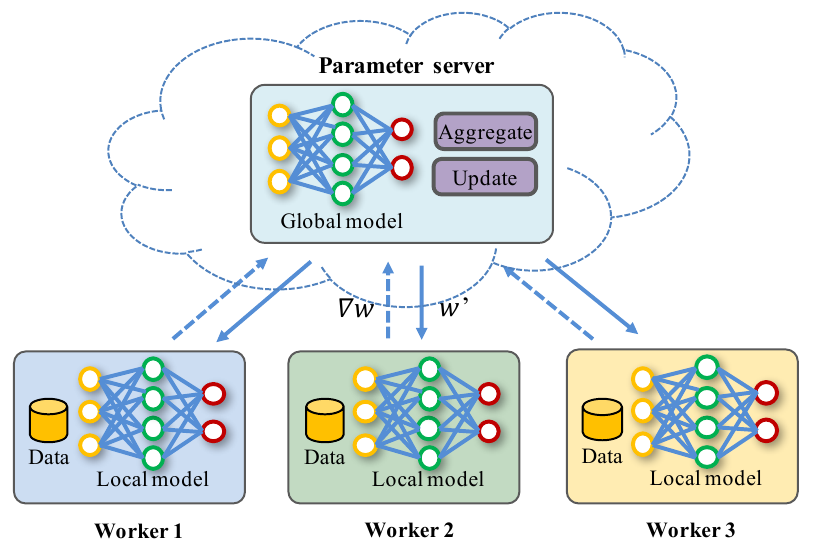
Figure 1. The architecture of a distributed training based on the parameter server